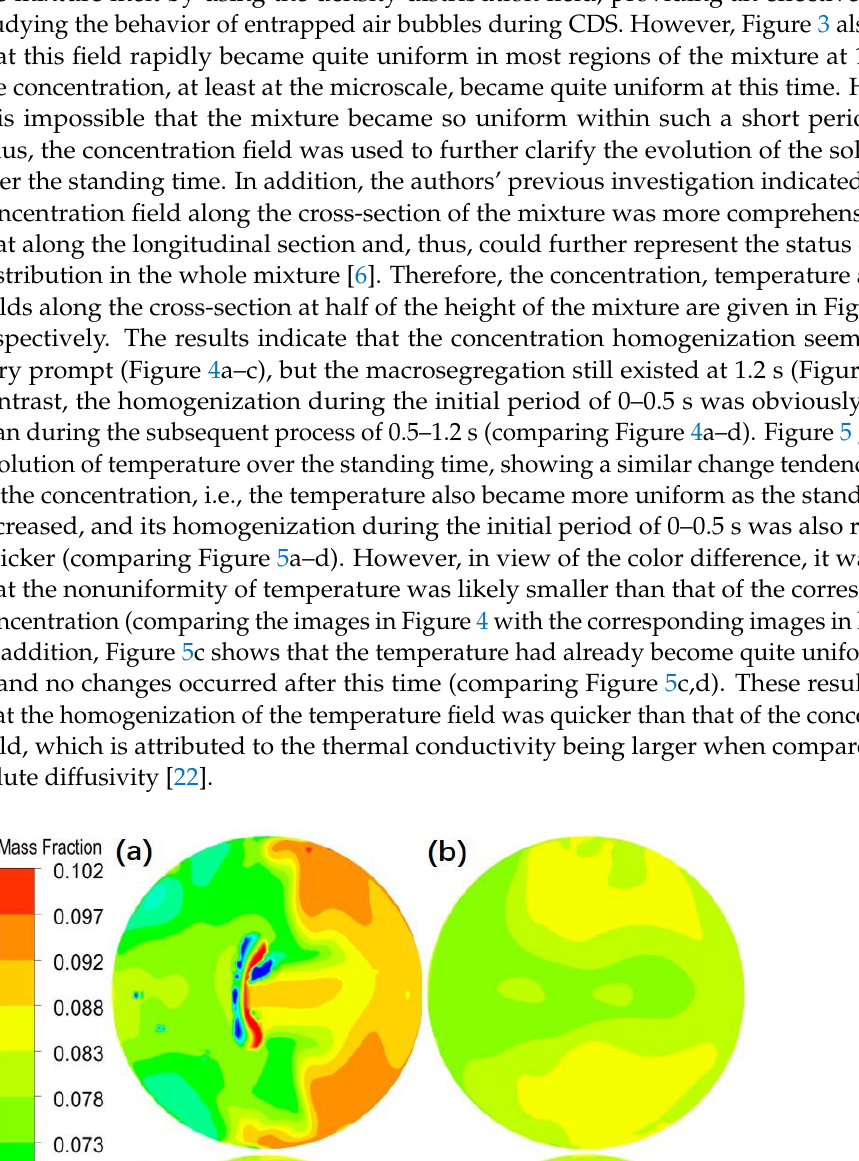
Figure 5. Temperature fields along the cross-section at half of the height of the mixture when stood for ( a ) 0 s, ( b ) 0.5 s, ( c ) 1.0 s and ( d ) 1.2 s.